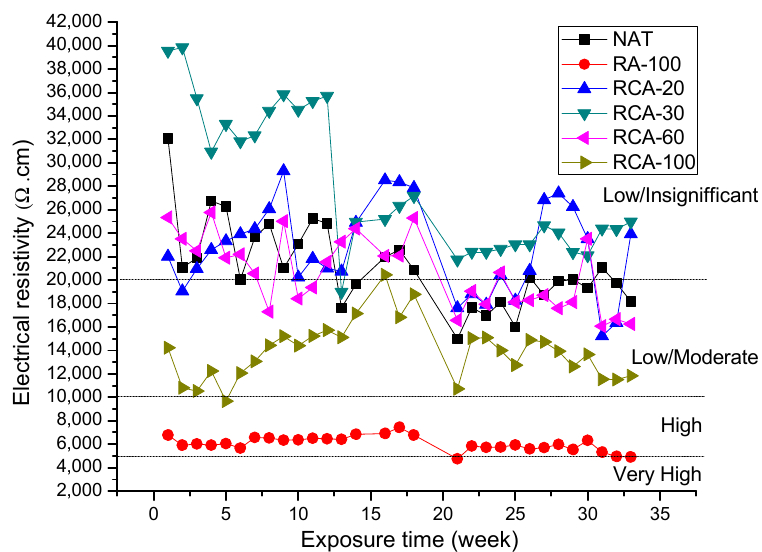
Figure 10. Evolution of ρ for the mixtures with RCA.